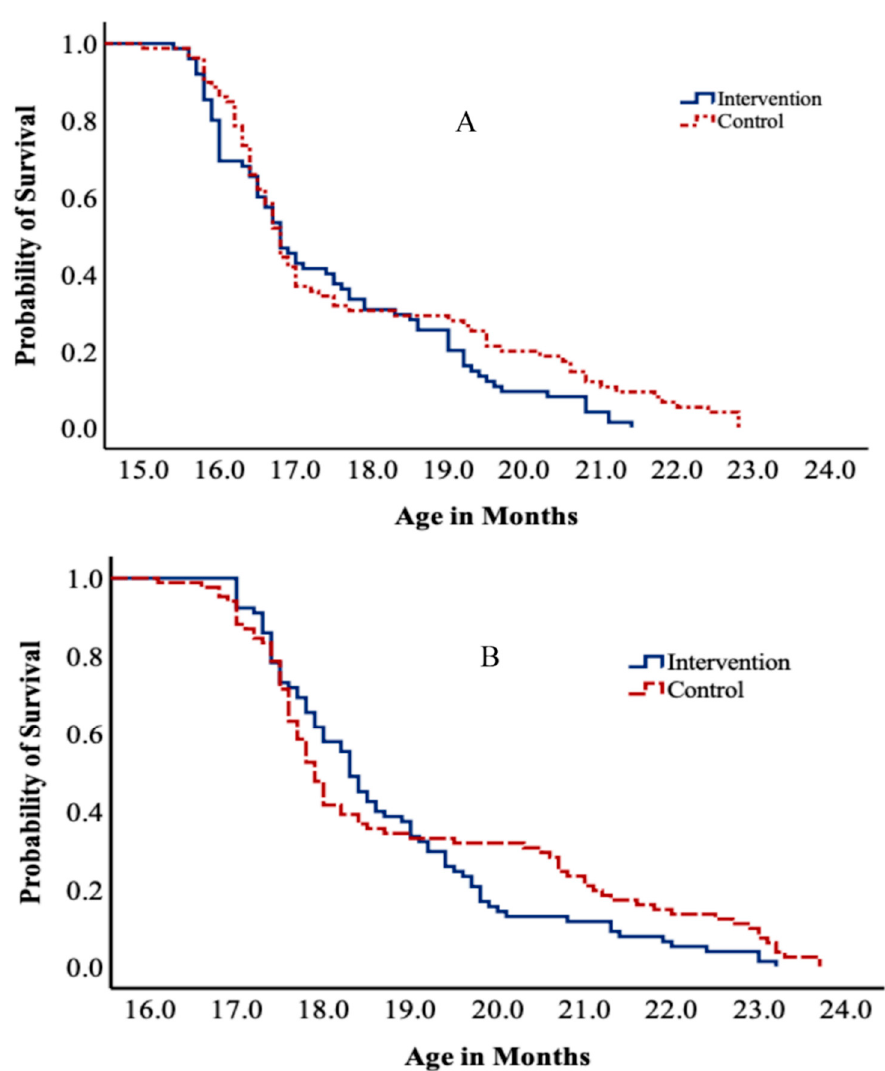
Figure 3. Kaplan–Meier curves of running ( A ) and kicking a ball ( B ) motor skills attainment among normal weight children at baseline in intervention and control.